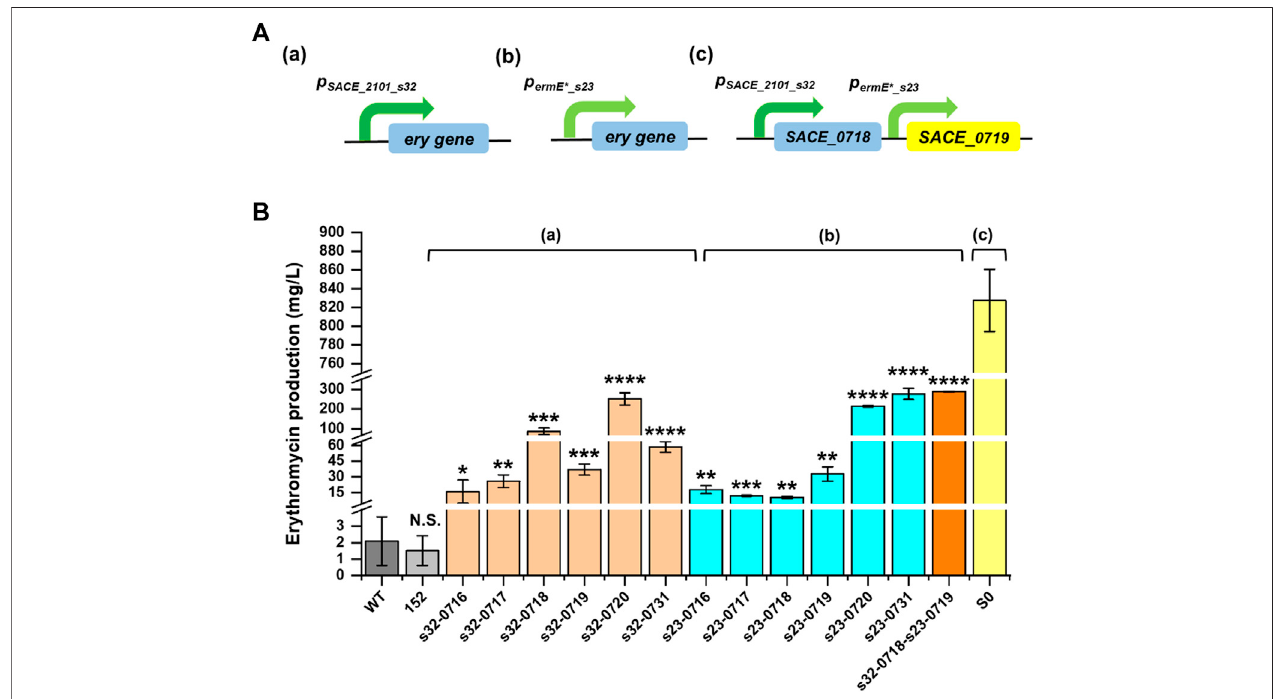
FIGURE 5 | Improving erythromycin production in S. erythraea NRRL 23338 by promoter engineering and gene overexpression. (A) Constructs of single-gene overexpression driven by p SACE_2101_s32 (a), and p ermE*_s32 (b), and combinational overexpression of SACE_0718 and SACE_0719 driven by p SACE_2101_s32 and p ermE*_s32 , respectively (c). ery genes: SACE_0716 , SACE_0717 , SACE_0718 , SACE_0719 , SACE_0720 , and SACE_0731 . (B) 24-well-plate fermentation results of S. erythraea NRRL 23338 (WT), S. erythraea /pSET152-hyg (152), overexpressing strains and high-producing strain S0. * p ≤ 0.05, ** p ≤ 0.01, *** p ≤ 0.001, **** p ≤ 0.0001, and N.S. indicated no signi fi cant difference (Student ’ s two-tailed t